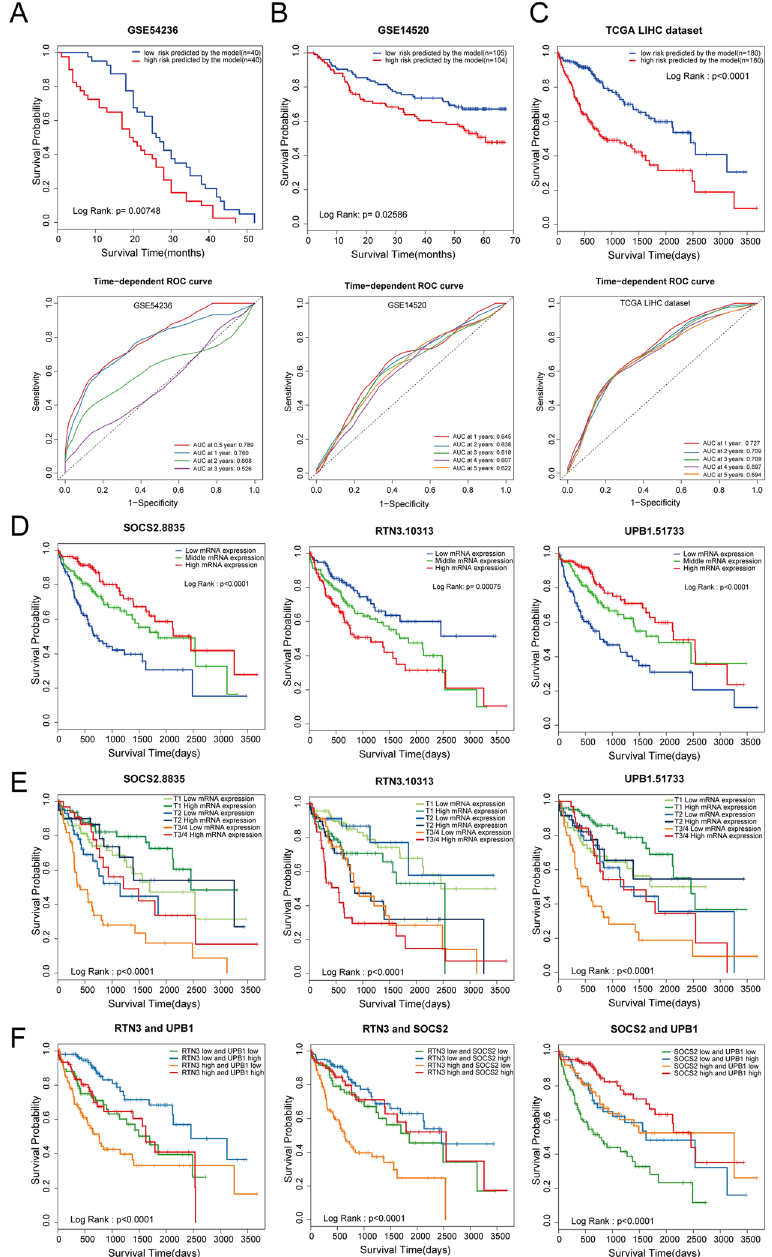
Figure 3. External and internal validation of the three-gene prognostic model. Two independent expression microarray HCC data sets GSE54236 ( A ) and GSE14520 ( B ) were downloaded from the GEO and were used as the signature validation cohort. The risk scores were calculated as Prognostic Index (PI) = 0.384 × RTN3- 0.561 × SOCS2-0.434 × UPB1. ( C ) Kaplan-Meier curves of overall survival in the TCGA cohort stratified by the three-gene prognostic signature. We used the time-dependent ROC curve analysis to assessed the prognostic accuracy of the three-gene prognostic signature of the microarray data and LIHC dataset (Fig. 3A lower panel, Fig. 3B lower panel, Fig. 3C lower panel). ROC: receiver operator characteristic. AUC: area under the curve. ( D ) Kaplan–Meier curves of HCC patients based on the SOCS2 (left panel), RTN3 (middle panel), or UPB1 (right panel) expression level. 360 patients were sorted by the RSEM values of a gene, and the lower third of the patients was defined as the low mRNA expression, the upper third as high mRNA expression, thus divided patients into 3 groups. ( E ) The survival curve of HCC patients stratified by T stage and gene expression. Firstly, 360 patients were divided into two groups based on SOCS2 (left panel), RTN3 (middle panel), or UPB1 (right panel) expression. The cutoff value of high and low expression was set as the median. Then, patients were classified into three subgroups according to the T stage. ( F ) Survival curves of 360 HCC patients based on the combination of RTN3 and UPB1 (left panel), RTN3 and SOCS2 (middle panel), SOCS2 and UPB1 (right panel) expression. The cutoff value of high and low expression was set as the